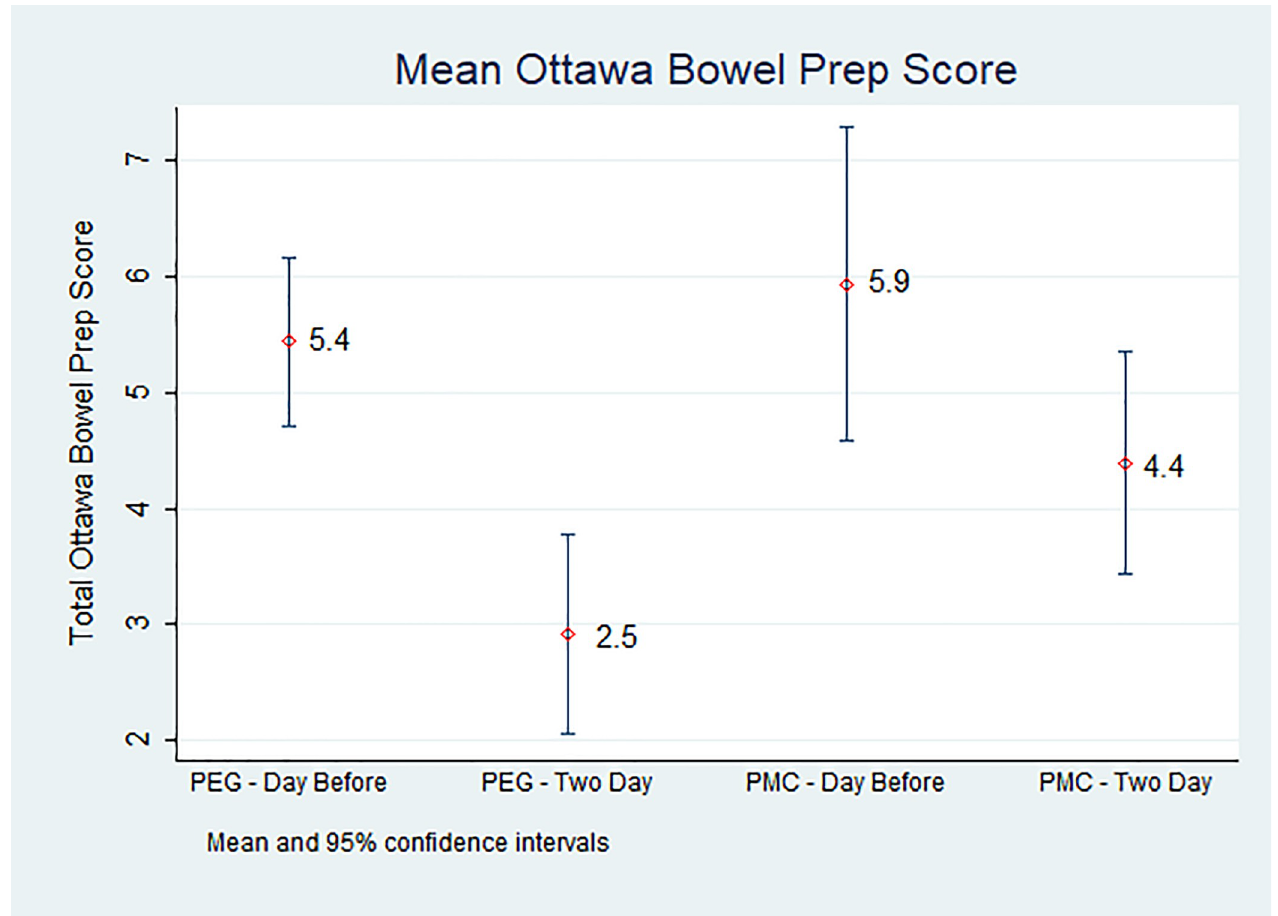
Fig 4. Unadjusted mean OBPS by preparation regimen and timing with 95% confidence intervals. The PEG two-day split group resulted in the best bowel preparation (OBPS 2.92; 95% CI:2.1-3.8), followed by PMC two day split (OBPS 4.39; 95% CI: 3.4-5.4). PMC and PEG one day-split groups both had higher OBPS scores (5.94; 95% CI: 4.6-7.3 and 5.44; 95% CI: 4.7-6.2, respectively) (Fig